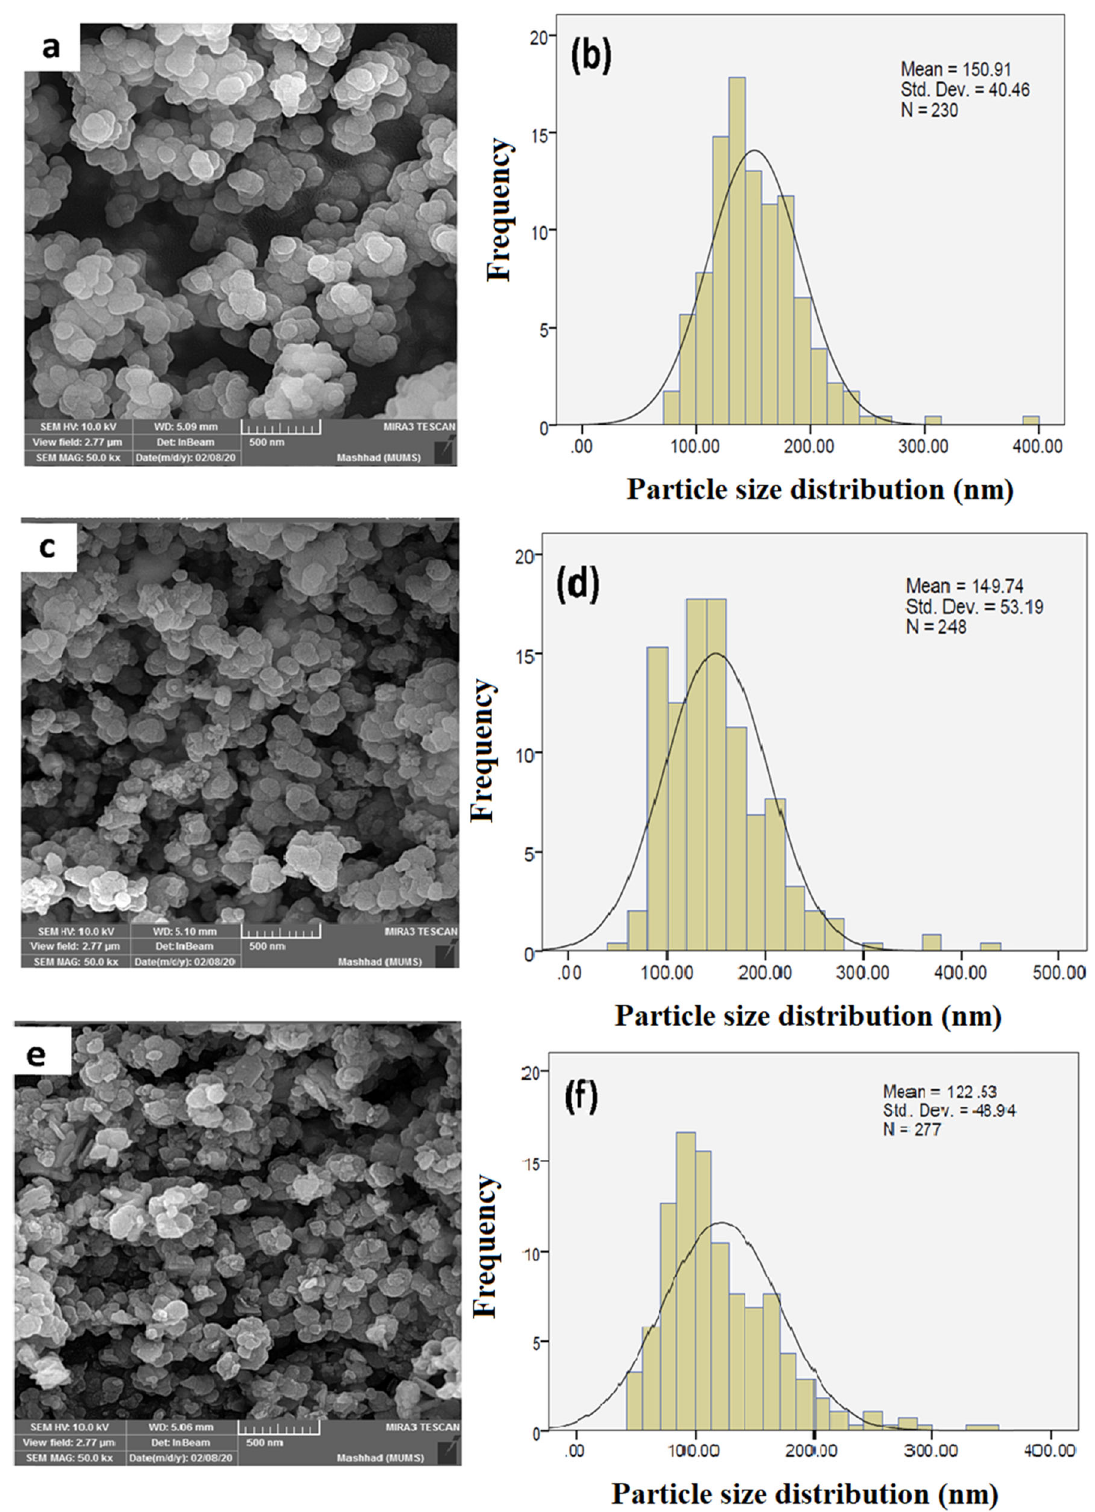
Fig. 4 FESEM images and size distributions of the UiO-66-NH 2 , CuS@UiO-66-NH 2 , and OXA-CuS@UiO-66-NH